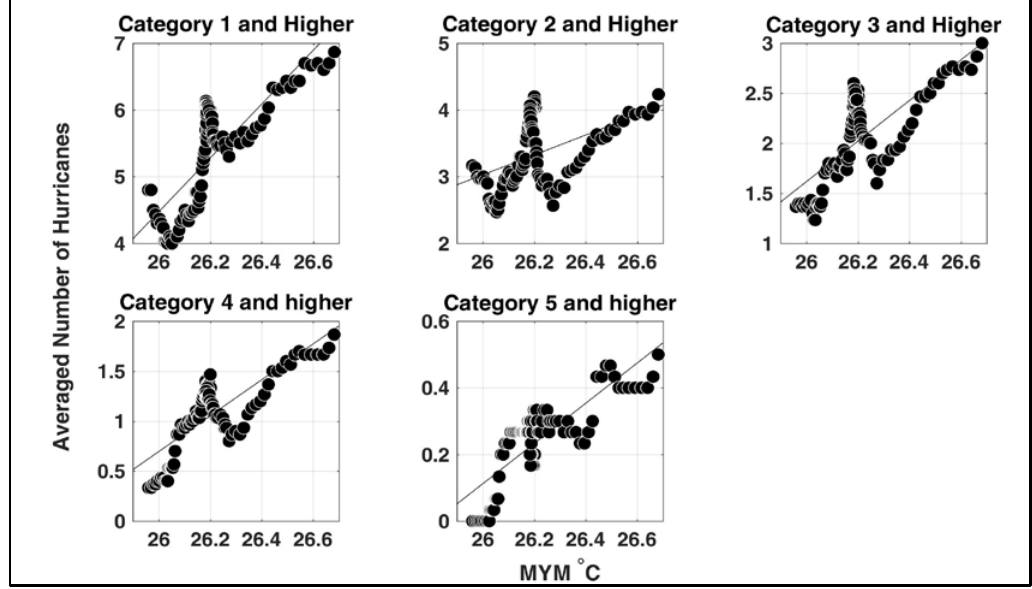
Figure 6. The relations between the averaged frequency of different SSHWS categories of hurricanes and averaged MYM values in the ACR from 1886 to 2017. The black lines are Least-Squares regression lines.